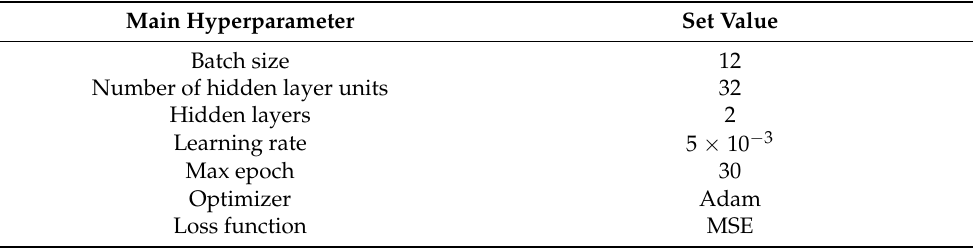
Table 1. Key parameters of